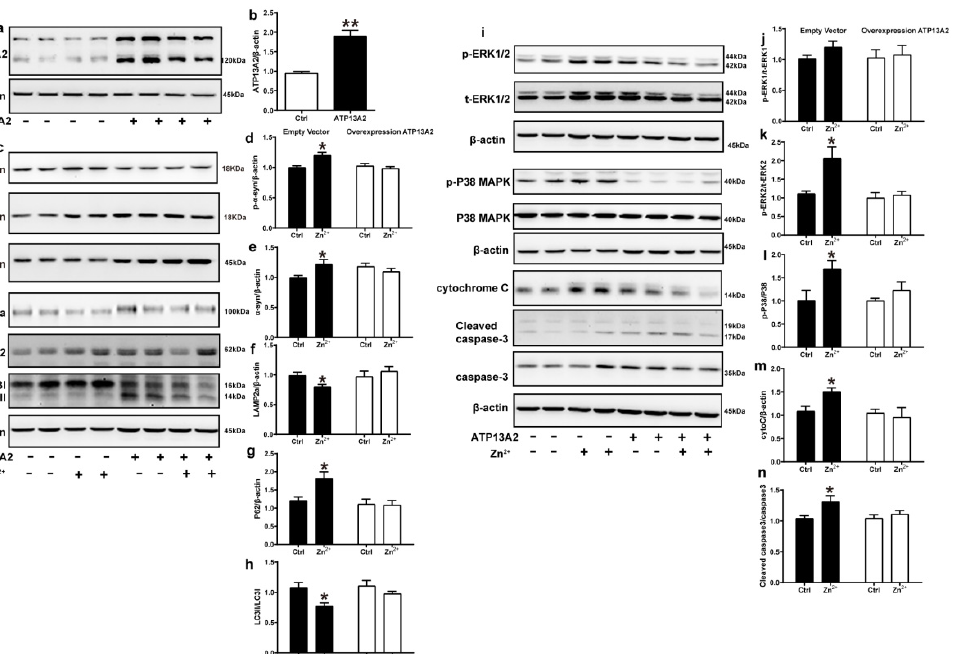
Figure 6. Overexpression of ATP13A2 inhibits zinc-induced autophagy–lysosome and ERK/P38 signaling pathways. The ATP13A2-pcDNA3.1-HA plasmid (ATP13A2 overexpression group) and the pcDNA3.1-HA empty vector (empty vector group) were transiently transfected into HEK293 α -synuclein-DsRed cells, and the ATP13A2 overexpression group and the empty vector group were treated or untreated with 75 μ M ZnSO4 for 12 h. ( a , b ) ATP13A2 levels were detected through Western blotting and quantitative analyses (a, representative pictures; b, quantification). Autophagy–lysosome pathway (c, representative pictures; d-h quantification): the expression levels of p- α -synuclein ( c , d ), α -synuclein ( c , e ), LAMP-2a ( c , f ), P62 ( c , g ), LC3 I and LC3 II (( c , h ), quantification of ratio of LC3II to LC3I) were determined using Western blot analysis with β -actin as an internal control. Apoptosis pathway (( i ), representative pictures; j-n, quantification): the p-ERK1 ( i , j ), p-ERK2 ( i , k ), p-p38 ( i , l ), cleaved caspase 3 ( i , n ) levels and the total protein levels of ERK1/2, p38, caspase 3 and expression levels of cytochrome C ( i , m ) were determined via Western blotting with β -actin as an internal control. Data are represented as the means ± SEM of at least three independent experiments. * p <